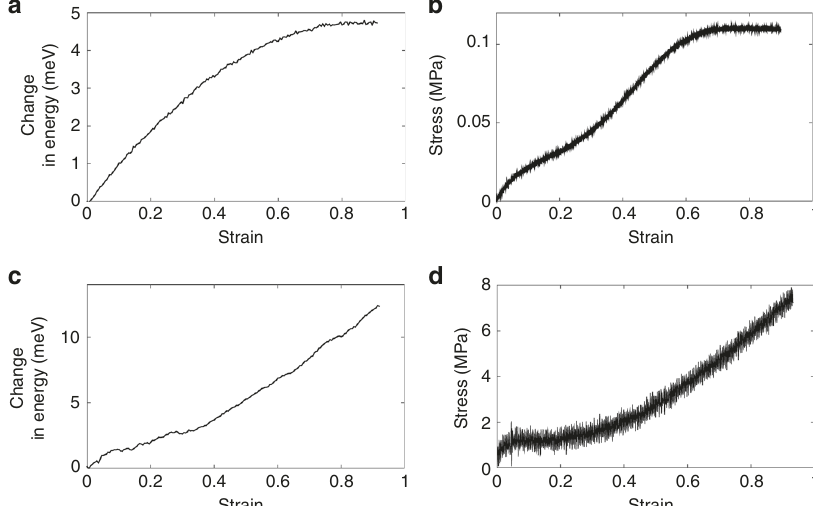
Fig. 3 Examples of opto-mechanical and mechanical tests on tQD-PBD and tQD-PCL polymer fi bers. Opto-mechanical and mechanical data were acquired separately. a Optically sensed fl uorescence tensile curve of tQD-PBD fi bers. The x -axis is tensile strain, while the y -axis is the magnitude of the PL emission maximum red-shift. b Corresponding tensile stress – strain curve of tQD-PBD fi bers measured using a typical uniaxial mechanical tensile tester. c Optically sensed fl uorescence tensile curve of tQD-PCL fi bers. The y -axis is the magnitude of the PL emission maximum red-shift. d Corresponding tensile stress – strain curve of tQD-PCL fi bers measured using a typical uniaxial mechanical tensile tester. Engineering stress and engineering strain are